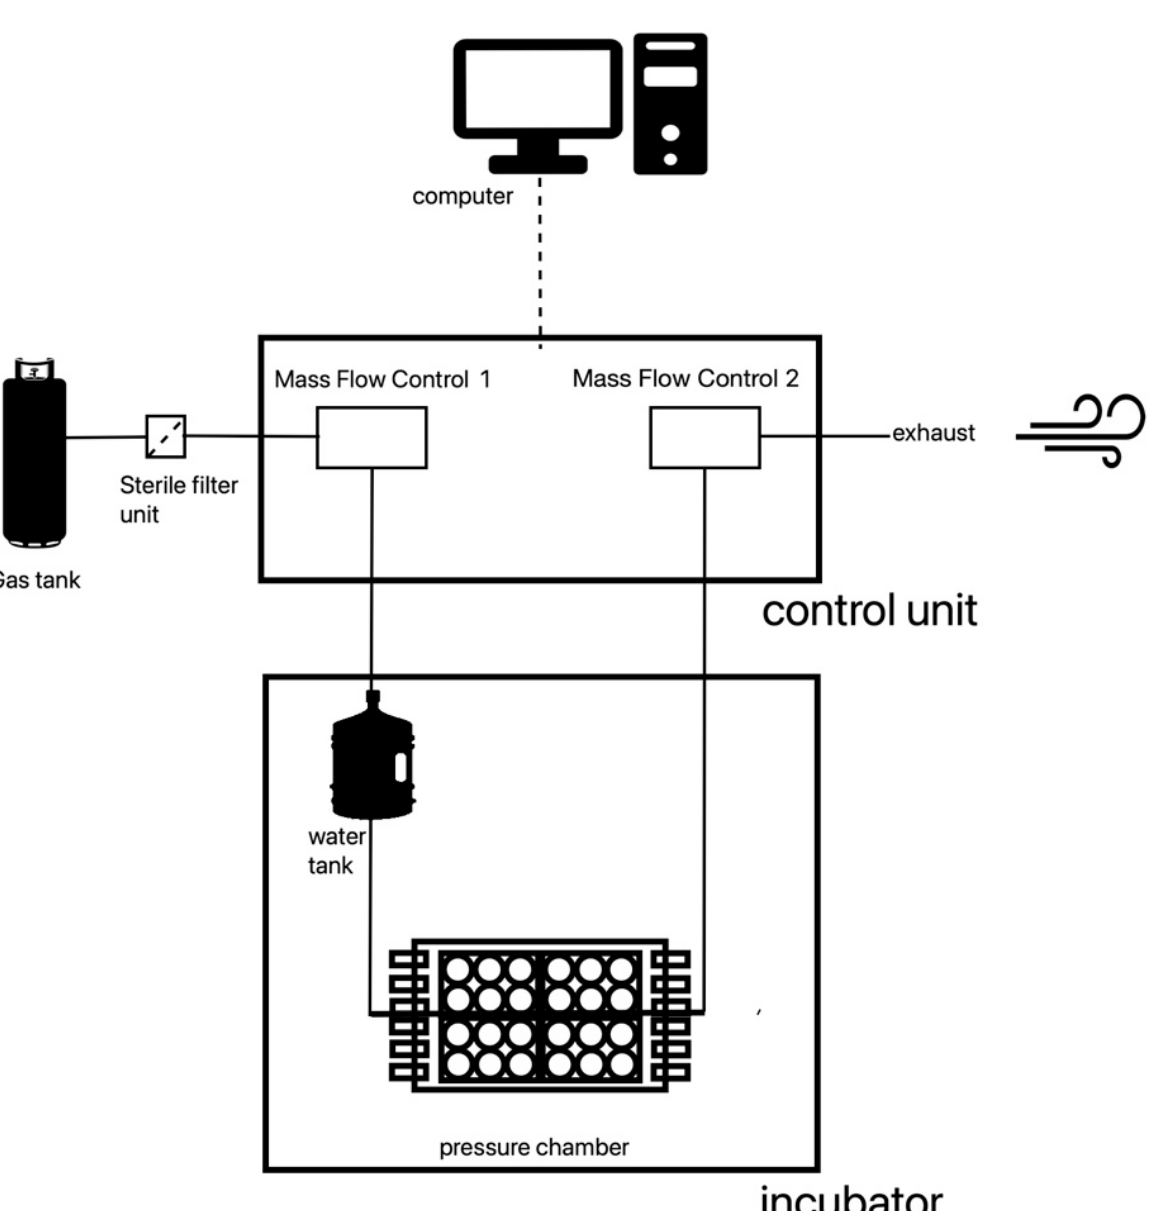
Figure 1. Pressurization system—schematic illustration. The gas is released from its container through a two-step pressure reducer. Before entering the chamber, the gas passes through a sterile filter, the first MFC vent (mass flow control) and a water tank. Then, the humidified and warmed gas enters the chamber. Immediately after the chamber, the gas passes a second MFC vent. The outflow of the second MFC vent is controlled by the computer. Through this outflow control, the pressure of 40 mm Hg is maintained consistently over an extended period. To ensure that the fluctuations in pressure are at a bare minimum, a computer program, which supervised the experiment, recorded the pressure in the system every minute. If a deviation of 1 mm Hg over a period longer than one minute was recorded, this section of the experiment was repeated. The pressure chamber is placed in an incubator to maintain a constant temperature of 37 ◦